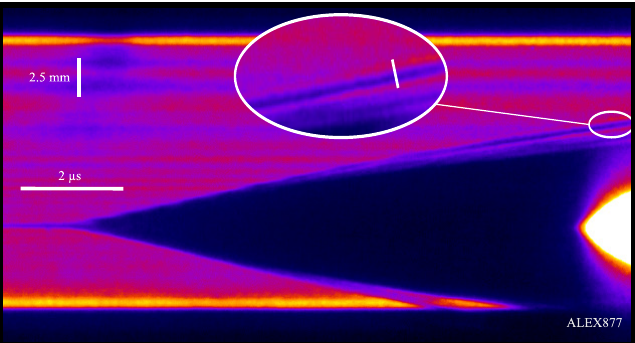
Figure 6. (Color online) streak image from an iron experiment with 10 kV in the capacitors bank. Inset shows the border between the shock wave and metal gas increase at the end of its